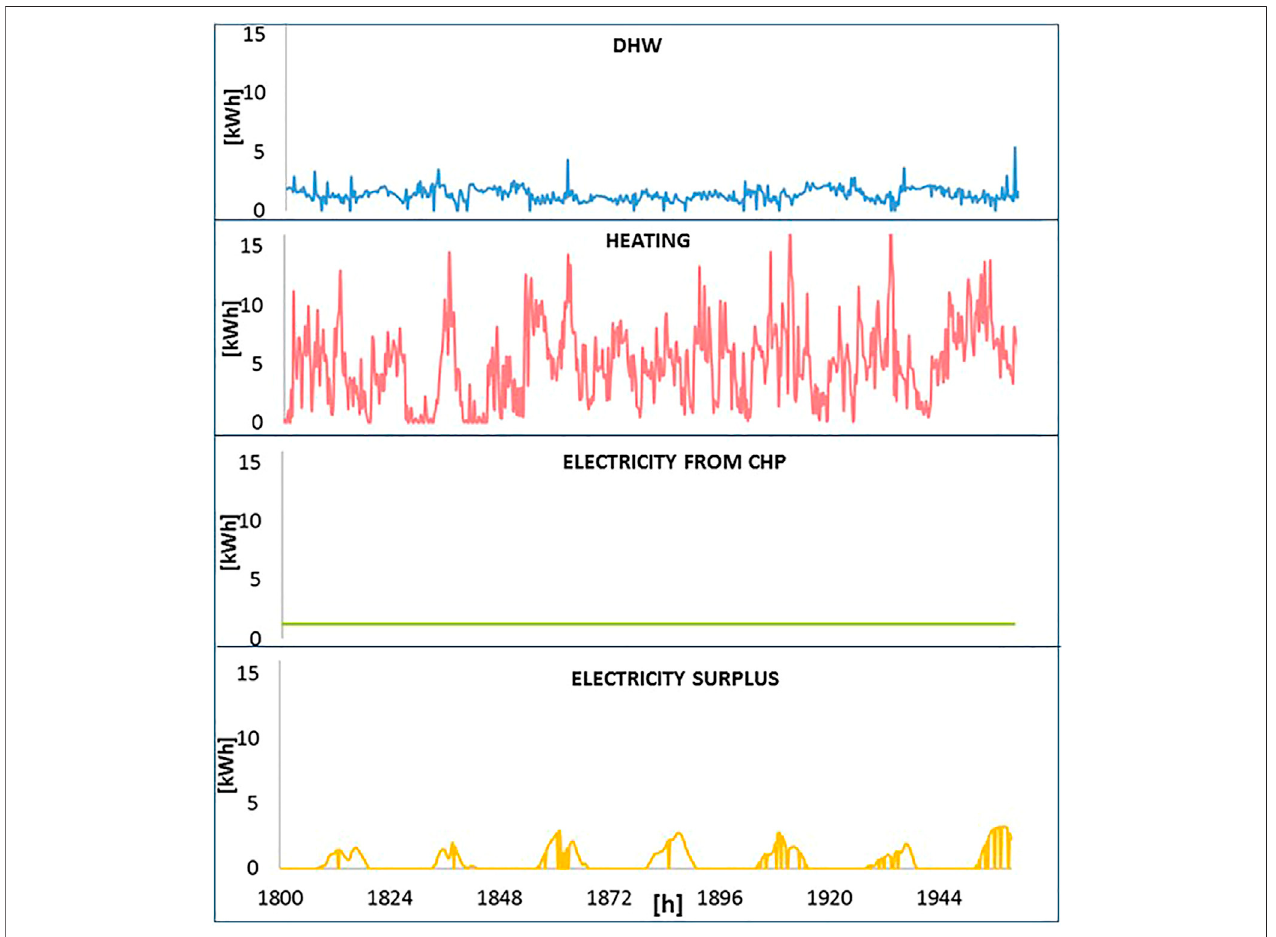
FIGURE 9 | Demand and electricity production along a week in March.